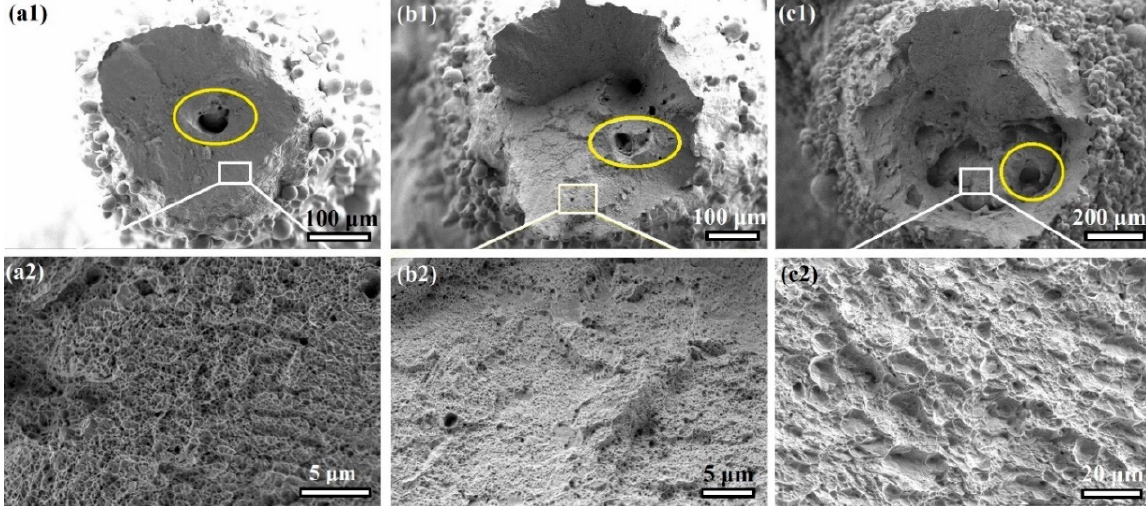
Figure 5. The fracture surfaces of the H-free specimens. SEM images of ( a ) T0.6, ( b ) T1, and ( c ) T1.4 after tensile testing. The magni fi cation views in ( a2 ), ( b2 ), and ( c2 ) are selected as indicated by the white rectangles in ( a1 ), ( b1 ), and ( c1 ).